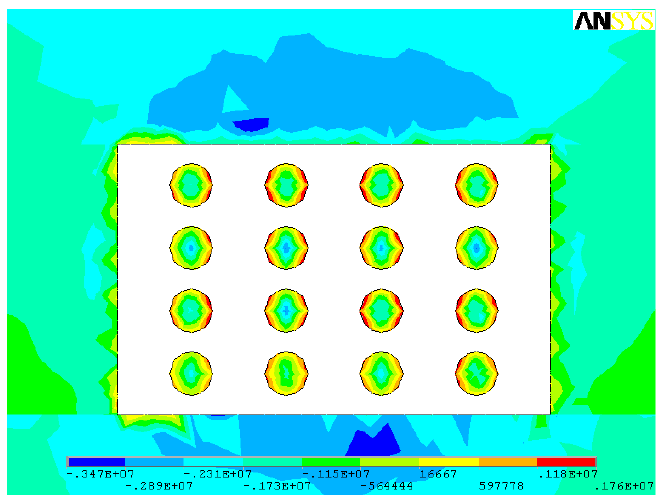
Figure 27. Maximum principal stress distribution of scheme 6 pillars at 1480 mL (parameters of scheme 6: stope height 3.5 m, pillar diameter 4 m, pillar spacing 6 m, pillar row spacing 9 m).